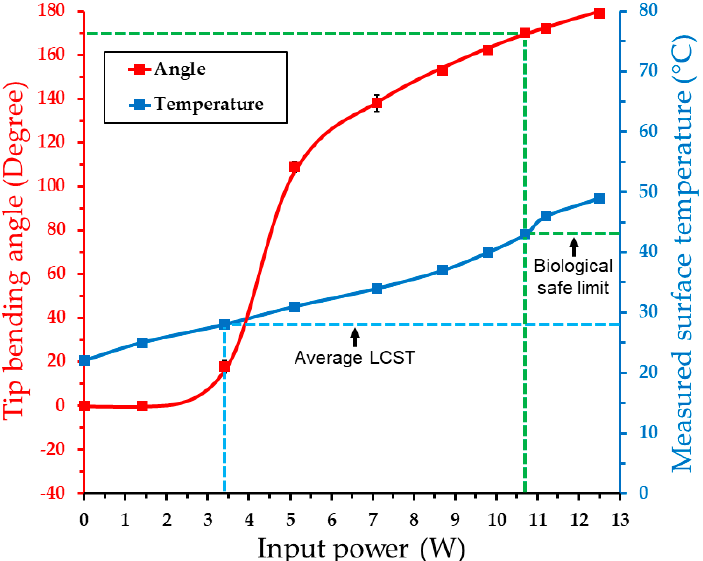
Figure 8. Measured angular displacement of the activated device as a function of the applied power to the embedded heater (measured device surface temperature from Figure 6b included for comparison).